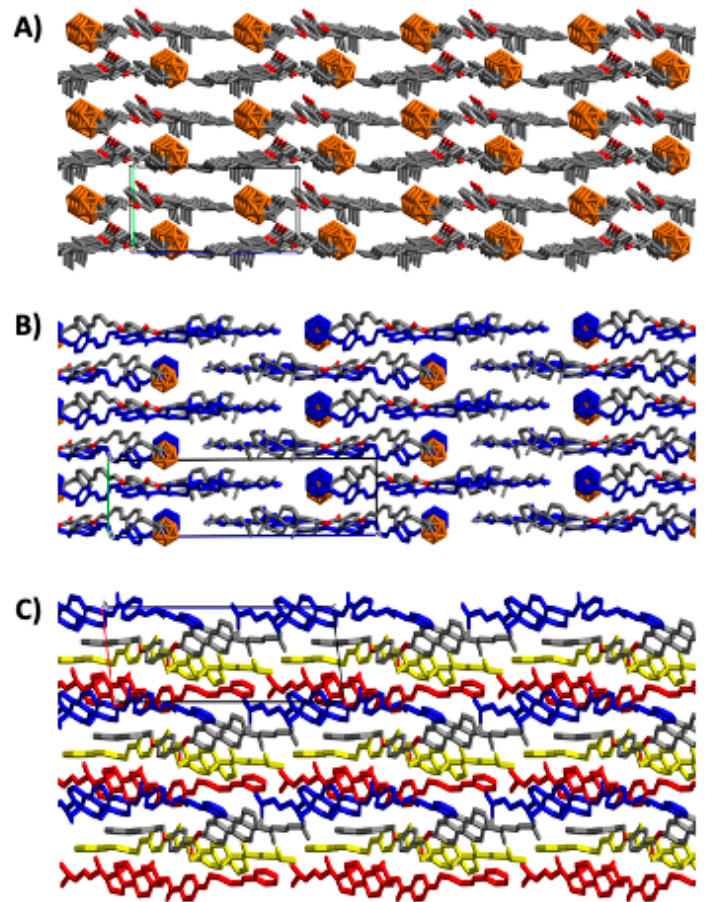
Figure 3. Views of crystal packings of M2 ( A ), M3 ( B ), and M5 ( C ). Independent molecules in the unit cells are colored. H atoms are omitted for clarity.